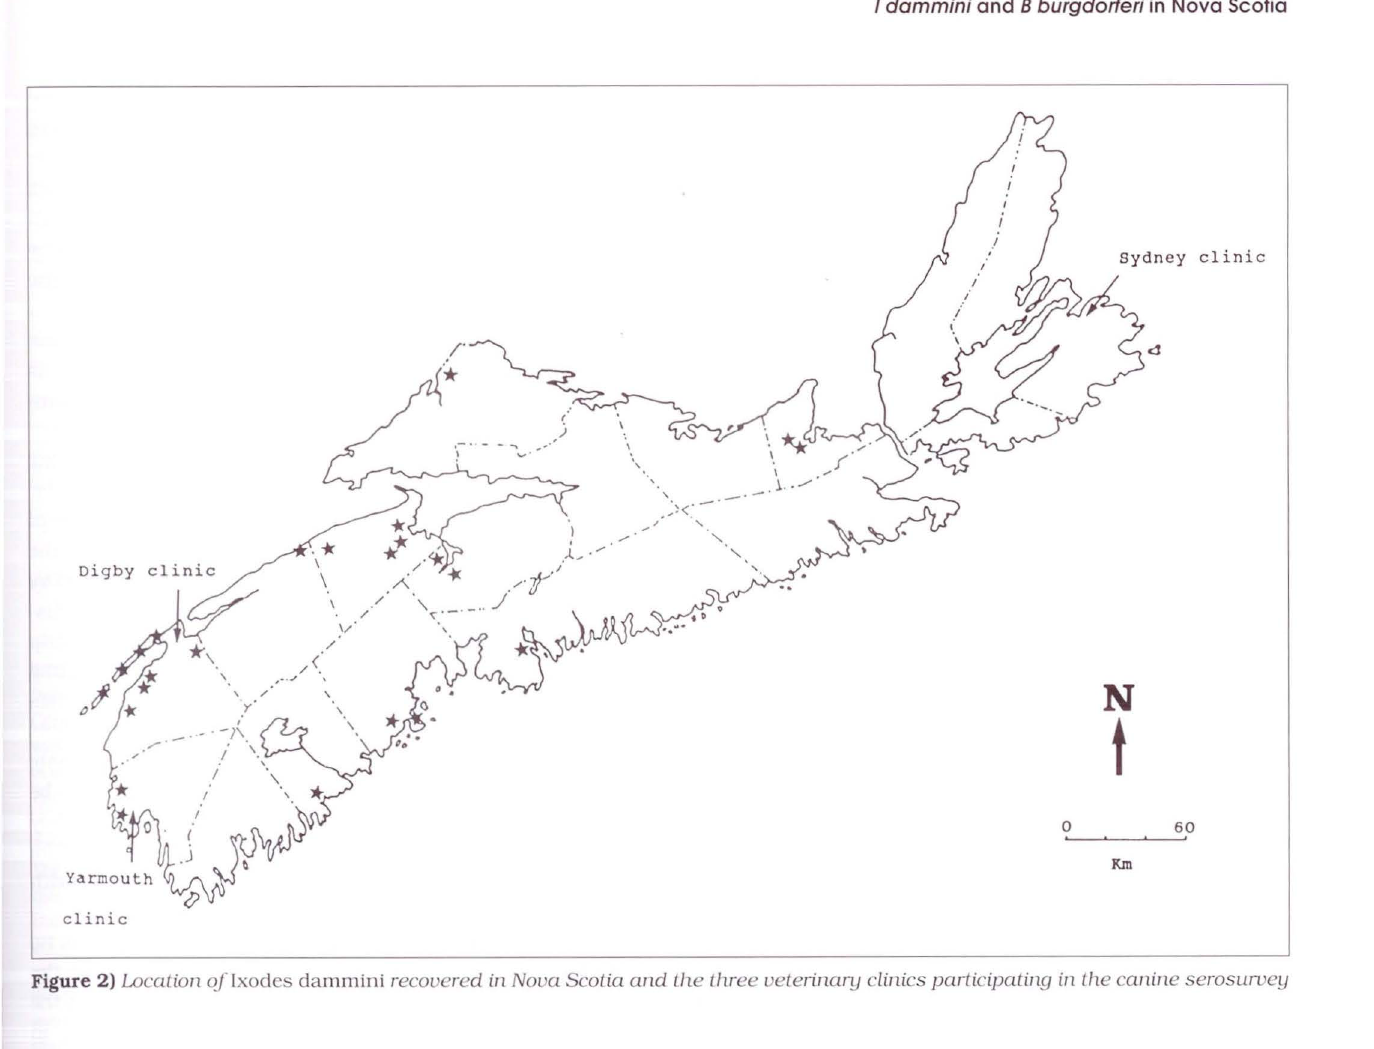
were sel for a lola! of 1017 trap-nights in numerous localities. These included Barton. Belliveau